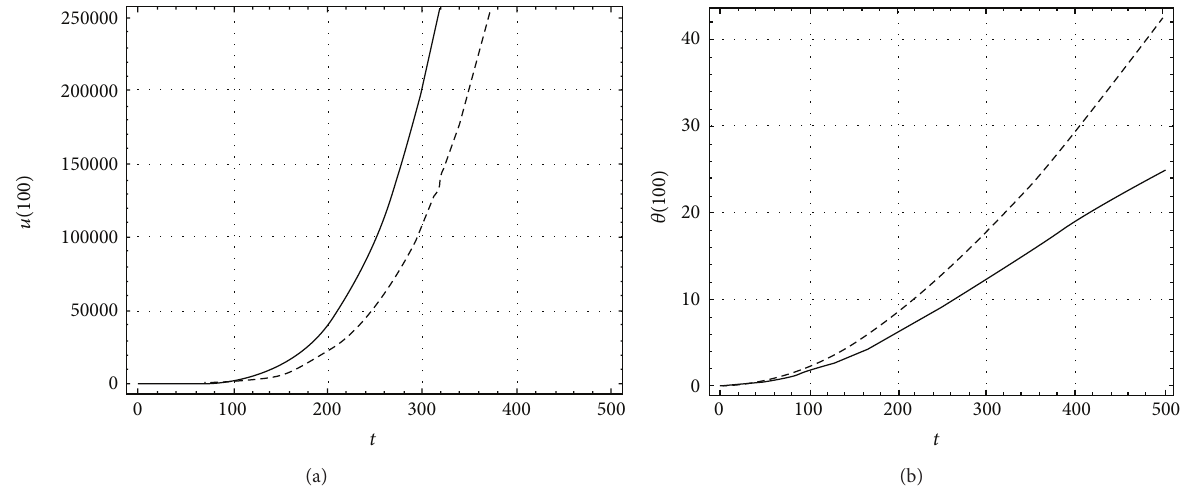
Figure 14: The displacement as a function of time and the temperature for two values of 𝛽 1 (LS) at 𝑥 = 100 , 𝑎 = 0.5 , 𝐴 = 0.001 , 𝑏 = 0.5 , = 0.05 , 𝛾 = 1 , 𝛿 = 0.8 , Ω = 0.1 , 𝜎 𝛼 = 1 , 𝛽 2